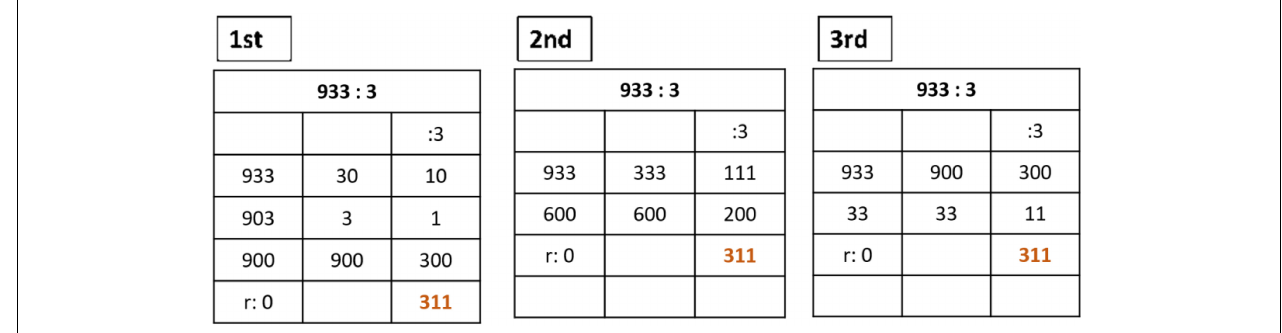
FIGURE 11 | Division algorithm with three columns in Open Algorithm Based on Numbers